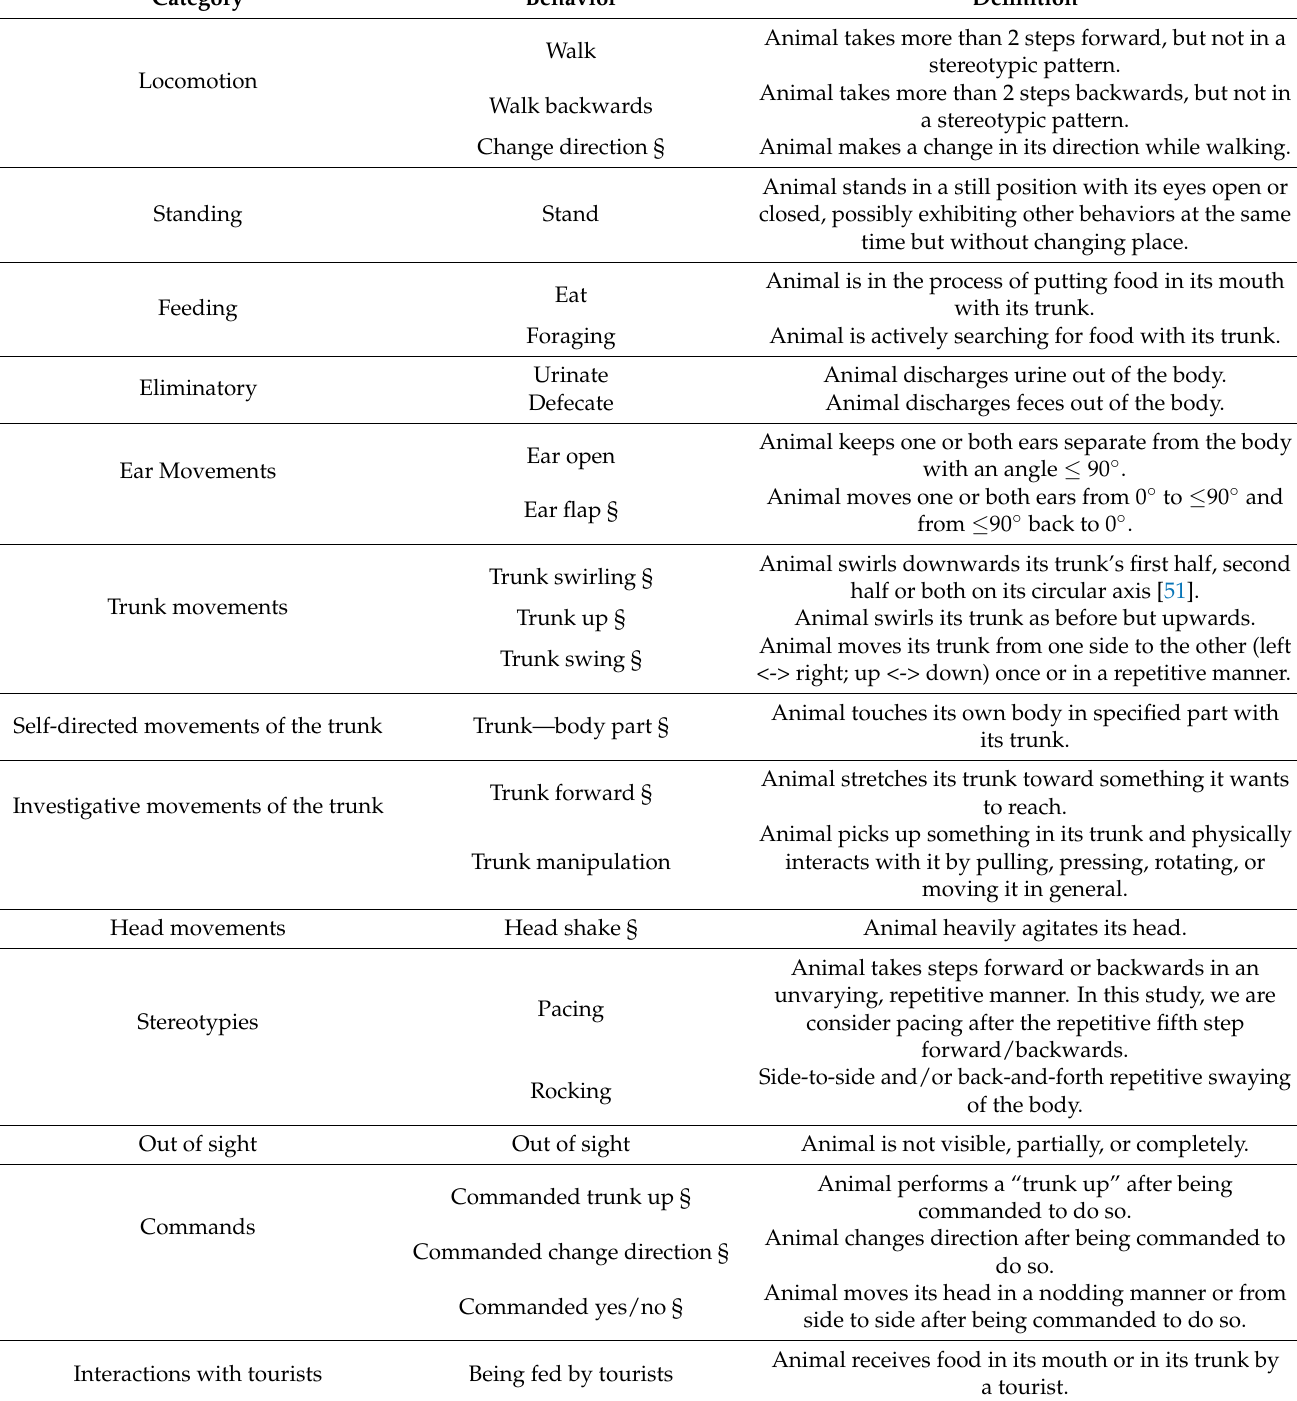
Table 2. Working ethogram. Behaviors marked with “§” represent events